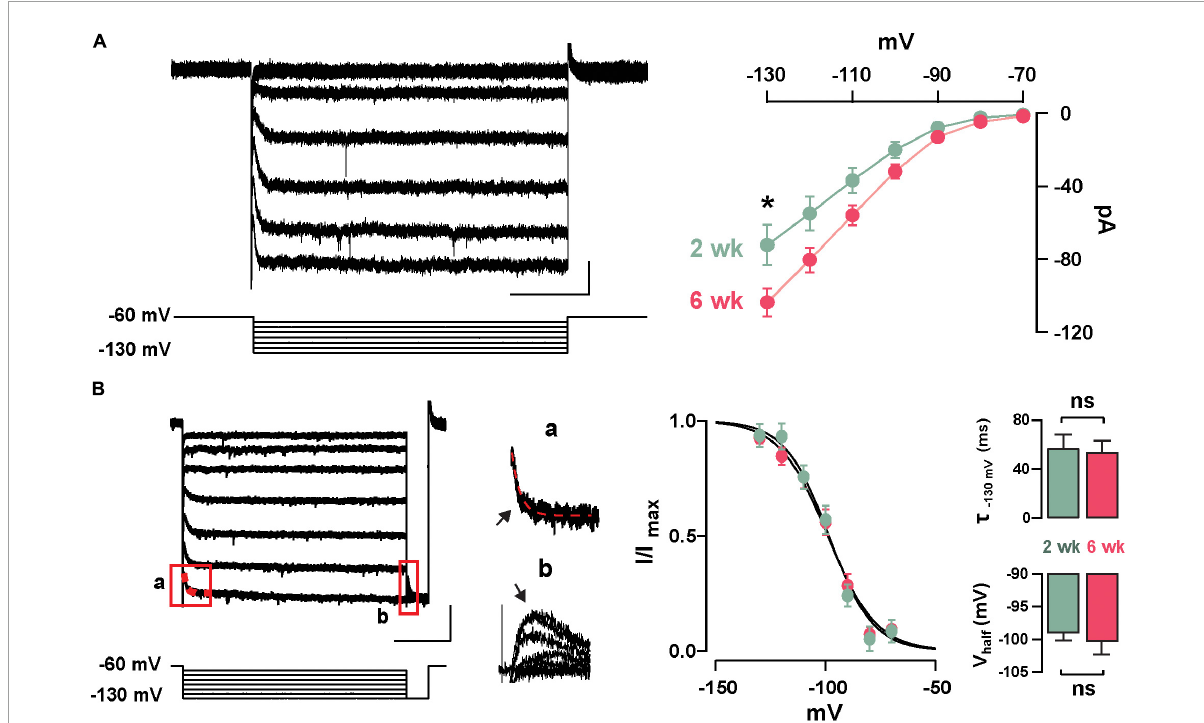
FIGURE2 Functional characteristics of I h in adult-born GCs. (A) Left: hyperpolarizing voltage steps from –60 to –130 mV (10 mV increments) elicited a hyperpolarization-activated inward current (I h ) in a GC 2 weeks post-labeling. The calibration is 20 pA and 500 ms. Right: The current–voltage (I–V) relationship for I h in adult-born GCs at 2 and 6 weeks post-injection shows an increase in I h amplitude with cell age (2 weeks, n = 17 cells; 6 weeks, n = 18 cells; current at –130 mV, * p = 0.03). (B) Left: hyperpolarizing steps from –60 to –130 mV with a test pulse to –130 mV were used to elicit a tail current. The calibration is 50 pA and 500 ms. Expanded currents traces show examples for a single exponential fit for estimating activation kinetics (a; τ = 43 ms, red dotted line), and for the tail current amplitude to determine voltage dependency (b). Right: Boltzmann fits for I h in GCs at 2 and 6 weeks post-labeling show no difference in the activation curve for I h . Summary bar graphs showing a similar average for the activation kinetic (upper right, τ 130 mV , p = 0.8) and half activation potential (bottom right, Vhalf, p = 0.6) for the two ages,